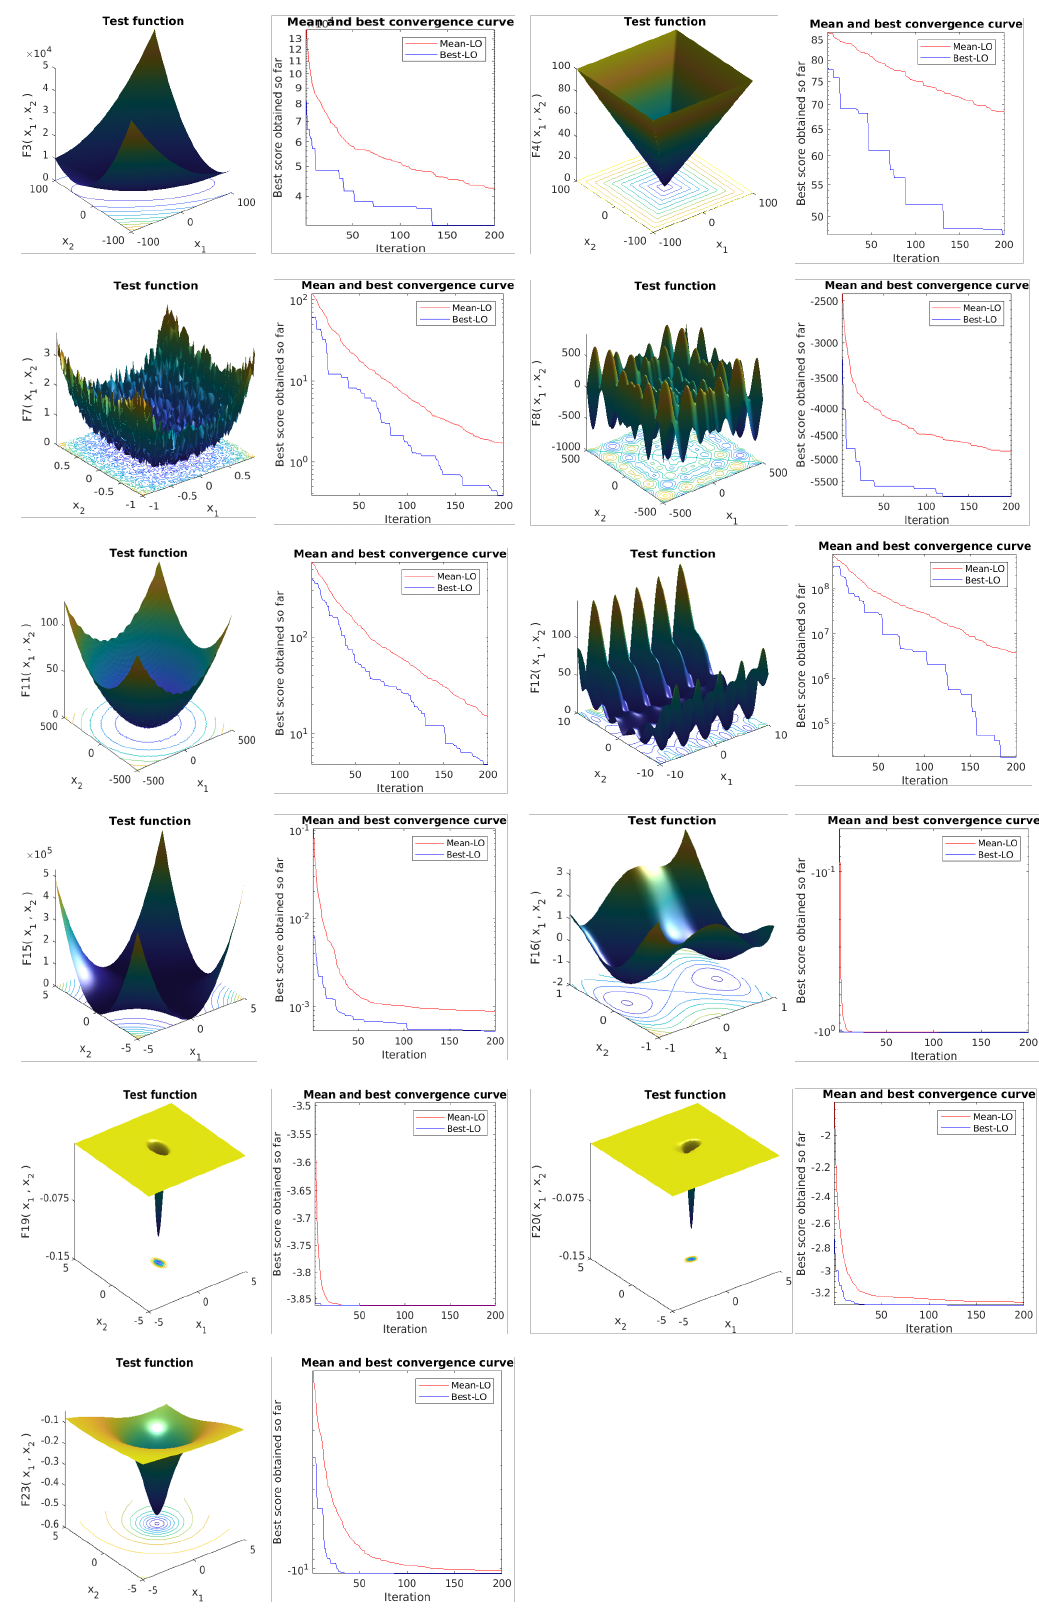
Figure 9. Functions and convergence